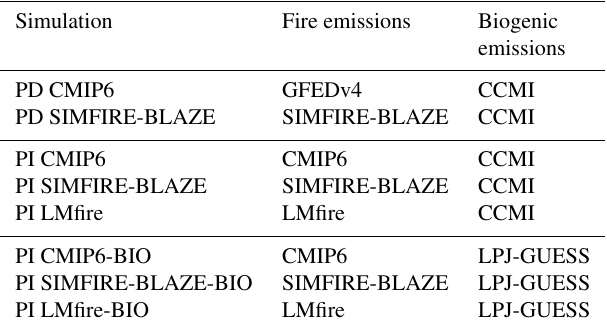
Table 1. Details of the TOMCAT–GLOMAP simulations performed in this